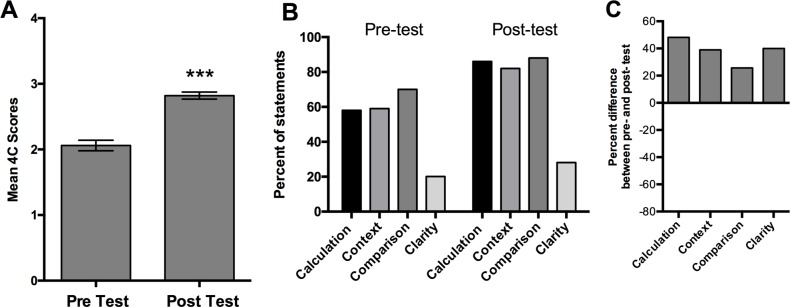
Using 4C scoring to measure quantitative writing before and after instruction.(A) Mean 4C scores of quantitative comparative statements on an identical pre- and post- test. (B) Percent of statements that contain each of the essential components of a QC statement. (C) Percent difference between the pre-test and post-test broken down by essential components of QC statements. (***t-test, p < 0.001) Error bars in A represent Standard Error of the Mean (SEM).